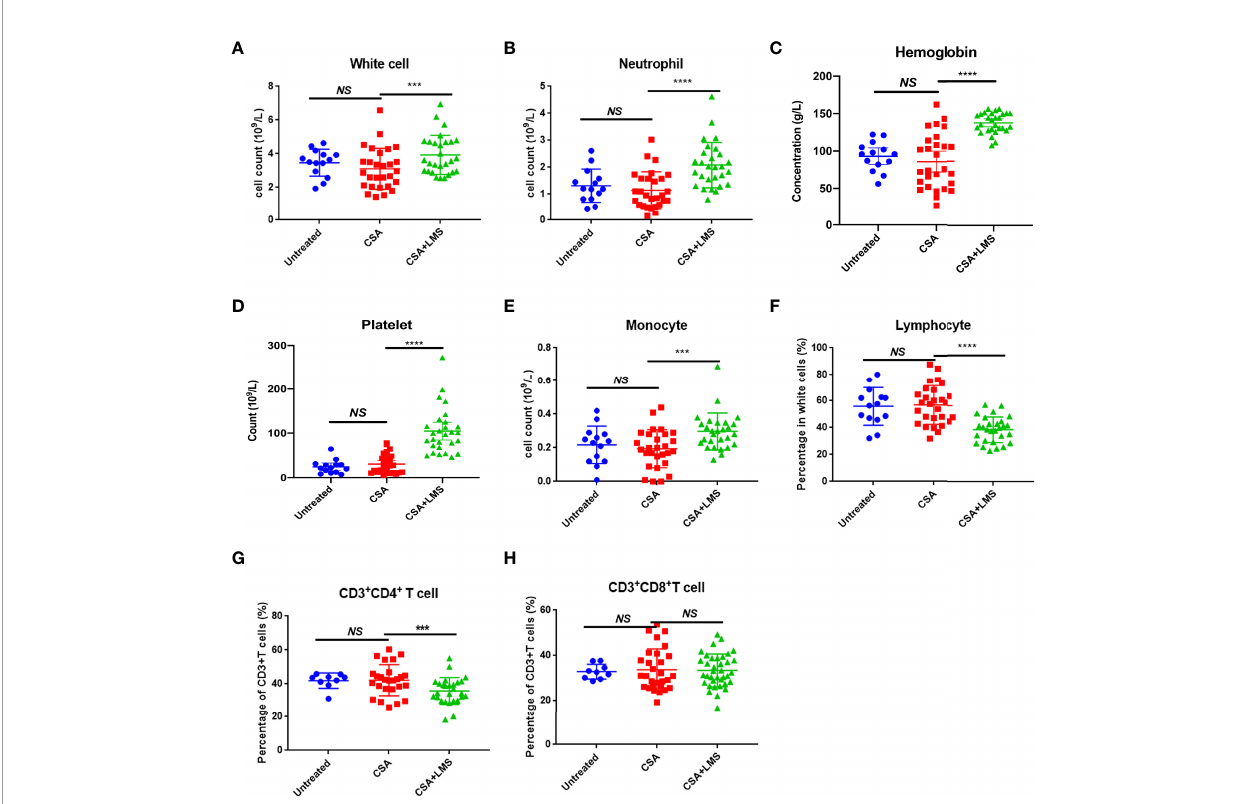
FIGURE 1 | Difference in immune cell types in the peripheral blood of NSAA patients before and after the administration of the CSA+LMS-based regimen. Twenty- eight NSAA patients who achieved poor response after 3 – 6 months of standard CSA therapy but achieved complete response (CR) or good partial response (GPR) after 3 – 6 months of CSA+LMS-based regimen were enrolled. (A – E) The levels of white blood cells, neutrophils, hemoglobin, platelets, and monocytes in NSAA patients at de novo (untreated), the time point after 3 – 6 months of standard CSA therapy with poor response before administration of the CSA+LMS-based regimen (CSA treated) and the time point after the CSA+LMS-based regimen with good response (CSA+LMS). (F – H) The percentage of lymphocytes in whole white cells, CD3 + CD4 + T cells in CD3 + T cells, and CD3 + CD8 + T cells in CD3 + T cells in these three stages of the cohort. *** p < 0.001, **** p <